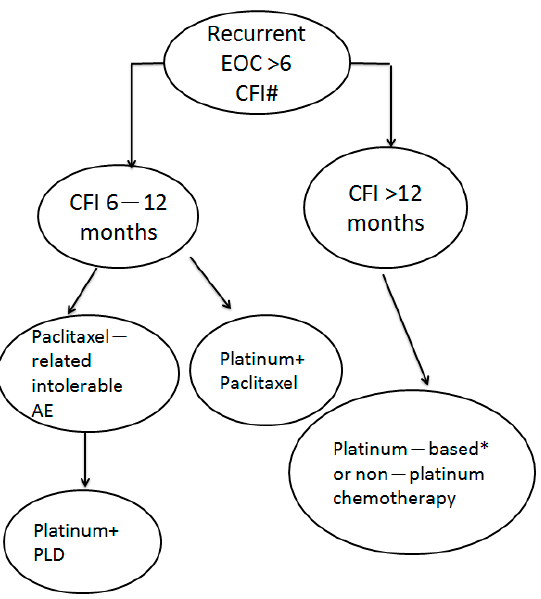
Figure 3. The proposed treatment of patients with PS recurrent ovarian cancer with different durations of TFIp. #: new agents are not available and patients not suitable for surgery. * platinum + liposomal doxorubicin could be used due to paclitaxel-induced intolerable adverse events such as peripheral neuropathy.